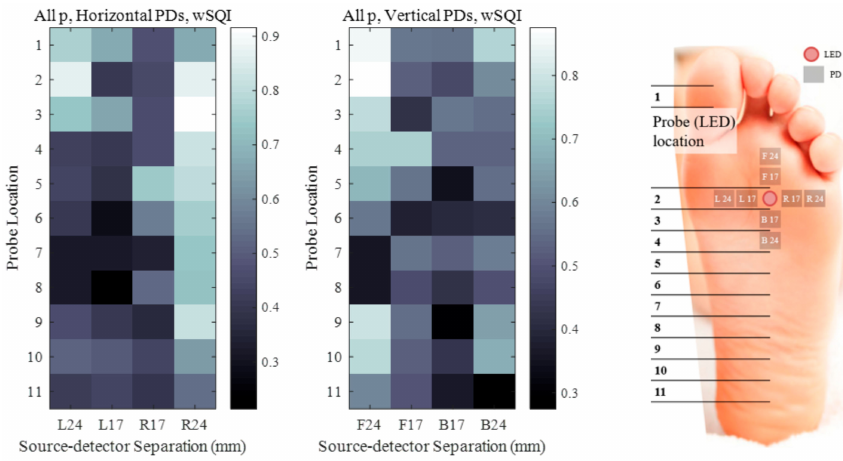
Figure 6. Foot PPG wSQI as a function of probe location and PD distance.